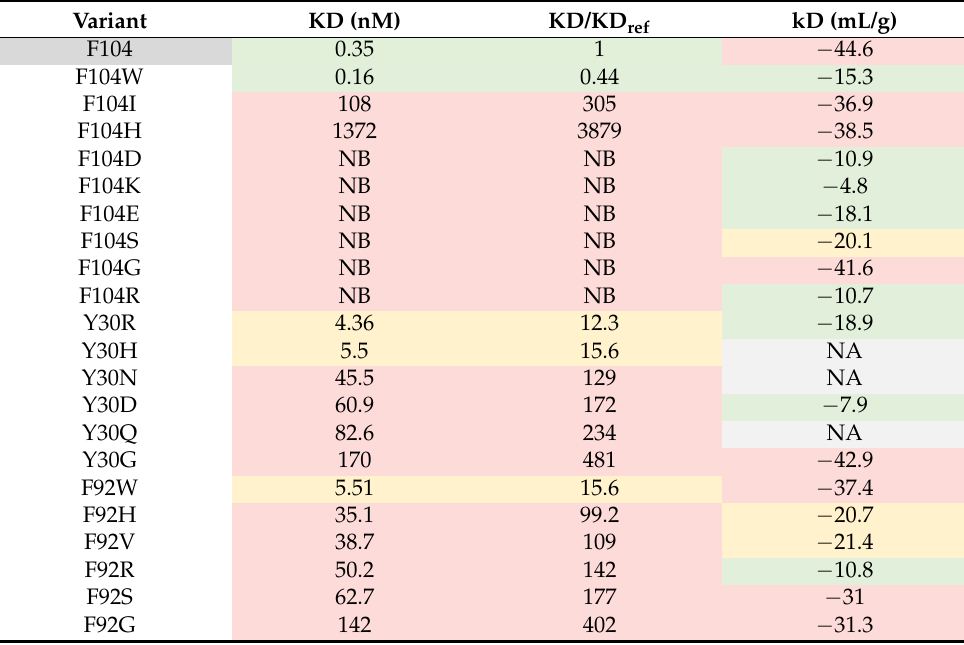
Table 1. BIAcore SPR and DLS results summary table for all variants. Tabulated are SPR KD (nM) values, the ratio of the measured KD and the HC-F104 reference KD (KD/KD ref ), and kD (mL/g) values obtained by DLS. The reference F104 is highlighted gray. All LC-Y30 and LC-F92 variants are site-directed mutants of the F104 variant. The single F104W variant with comparable BIAcore SPR KD to the reference is highlighted green. Variants with 10–20 × differences in binding relative to the variant are highlighted yellow, and those with greater than 20-fold difference in SPR binding or non-binding (NB) are highlighted red. kD (mL/g) measured by DLS is color coded in terms of degree of self-association (greater than − 20 mL/g, green; − 20 to − 29 mL/g, yellow; − 30 mL/g or less, red). “NA” denotes no